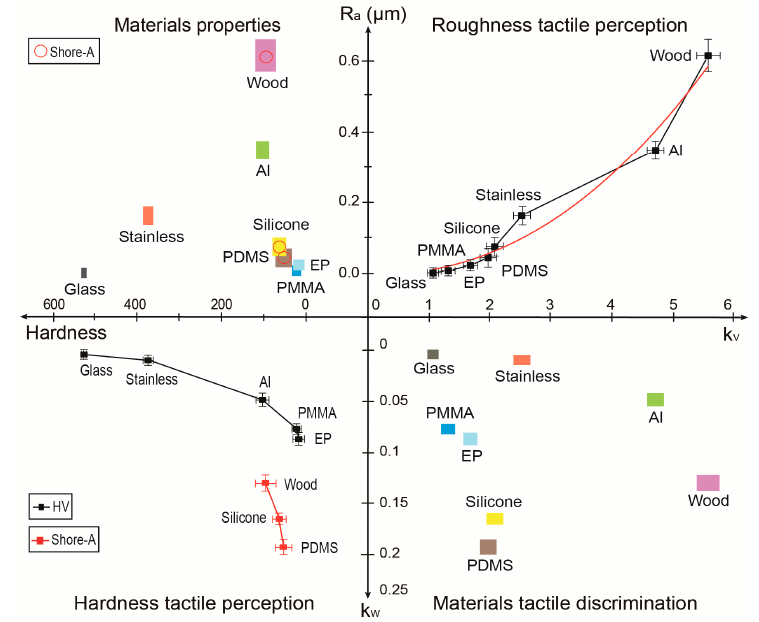
Figure 8. Cross-quadrant map of eight common materials’ tactile discrimination by traditional surface roughness, material hardness, and our new approach of k v and k w values.